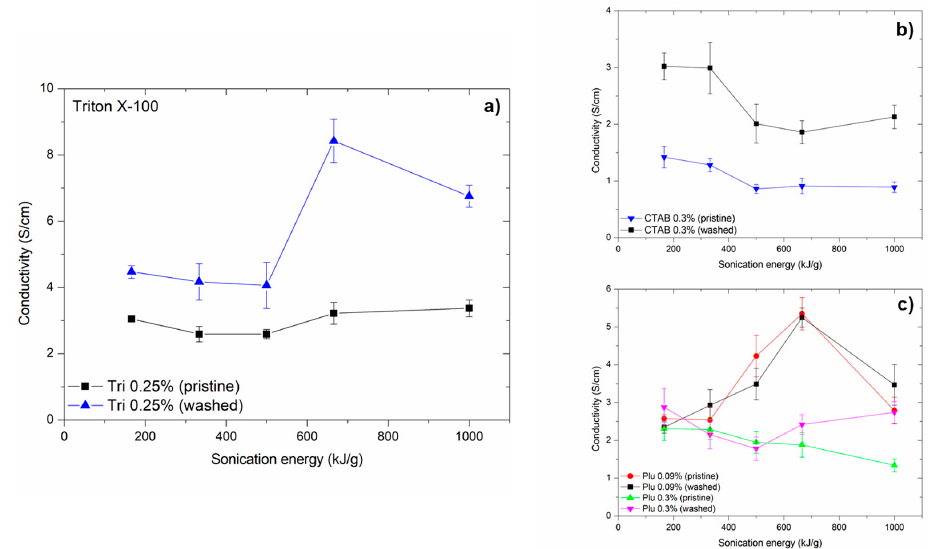
Figure 2. Conductivity of nanocomposite films before and after ( a ) Triton X-100 surfactant removal, ( b ) CTAB surfactant removal, and ( c ) Pluronic surfactant removal.